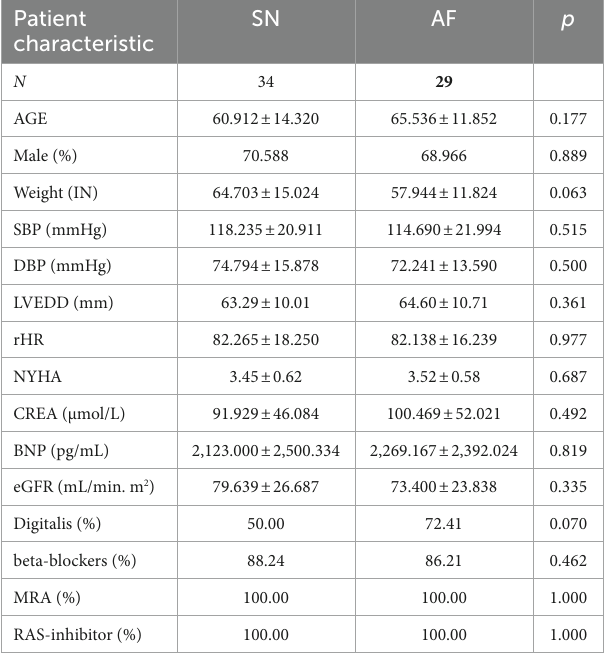
TABLE 1 Baseline characteristics of AdHF patients with SR and AF (Mean ± SD). Patient